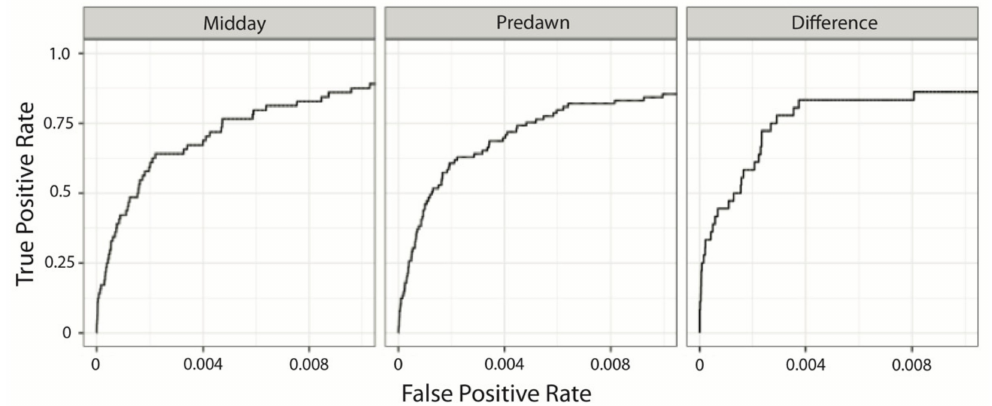
Figure 7. The 0 to 0.01 portion of the false positive rates of receiver operator characteristic curves for the FSL logistic regression models for midday, predawn and difference imagery, Pisgah Lava Field, Mojave Desert, CA, USA. False positive rate represents the percentage of landscape cells incorrectly predicted as caves, while the true positive rate is the proportion of caves correctly classified as